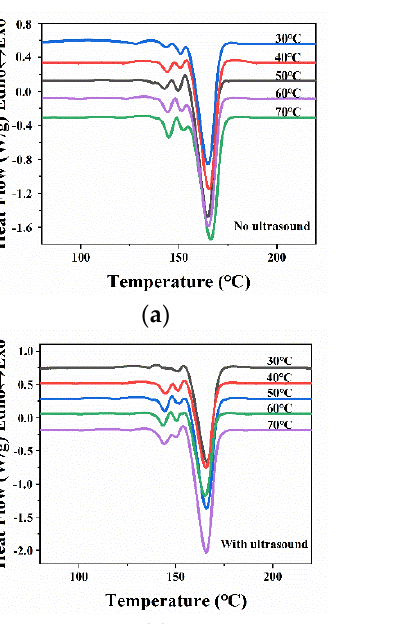
Figure 10. ( a ) XRD atlas of WBG-PP without ultrasound. ( b ) The w c,x and K β values of WBG-PP without ultrasound. ( c ) XRD atlas of WBG-PP with ultrasound. ( d ) The w c,x and K β values of WBG-PP with ultrasound. ( e ) Contrast of the FWHM of the diffraction peaks on the β -crystal plane with and without ultrasound.